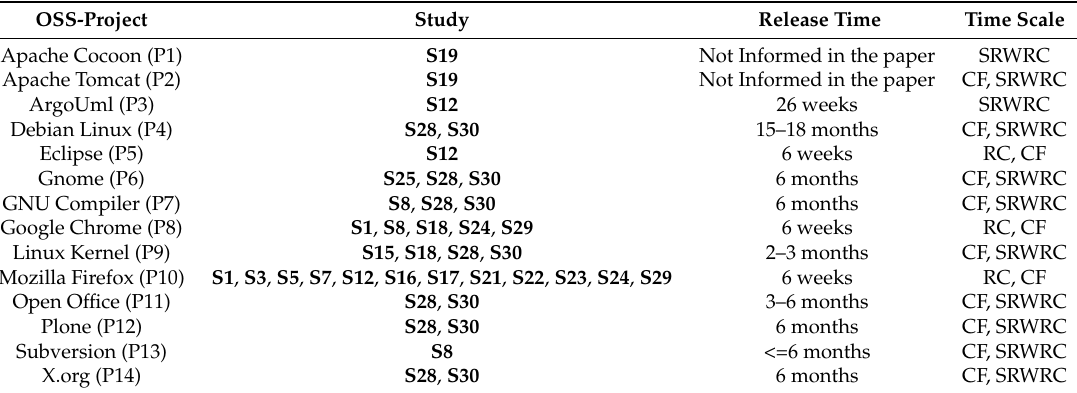
Table 3. Projects-Studies-Releases-Time